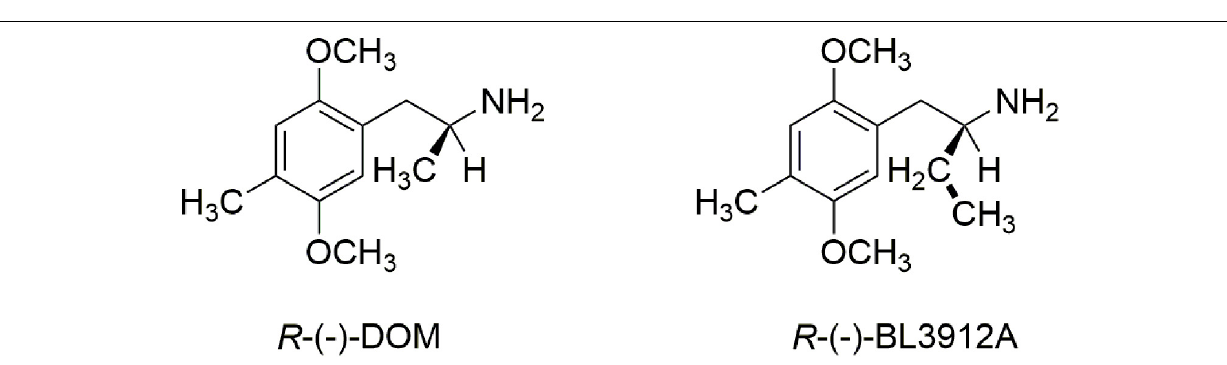
significant CNS activity at doses up to 270 mg (13), whereas DOM is orally active in the 5–10 mg